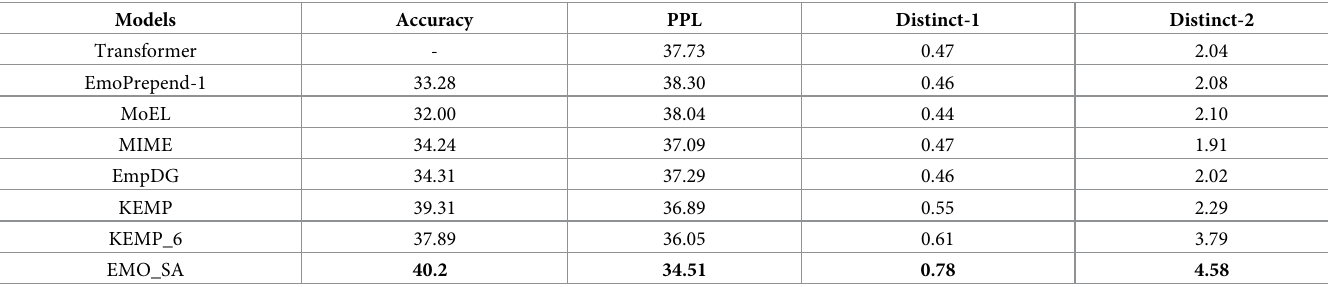
Table 2. Automatic evaluation of